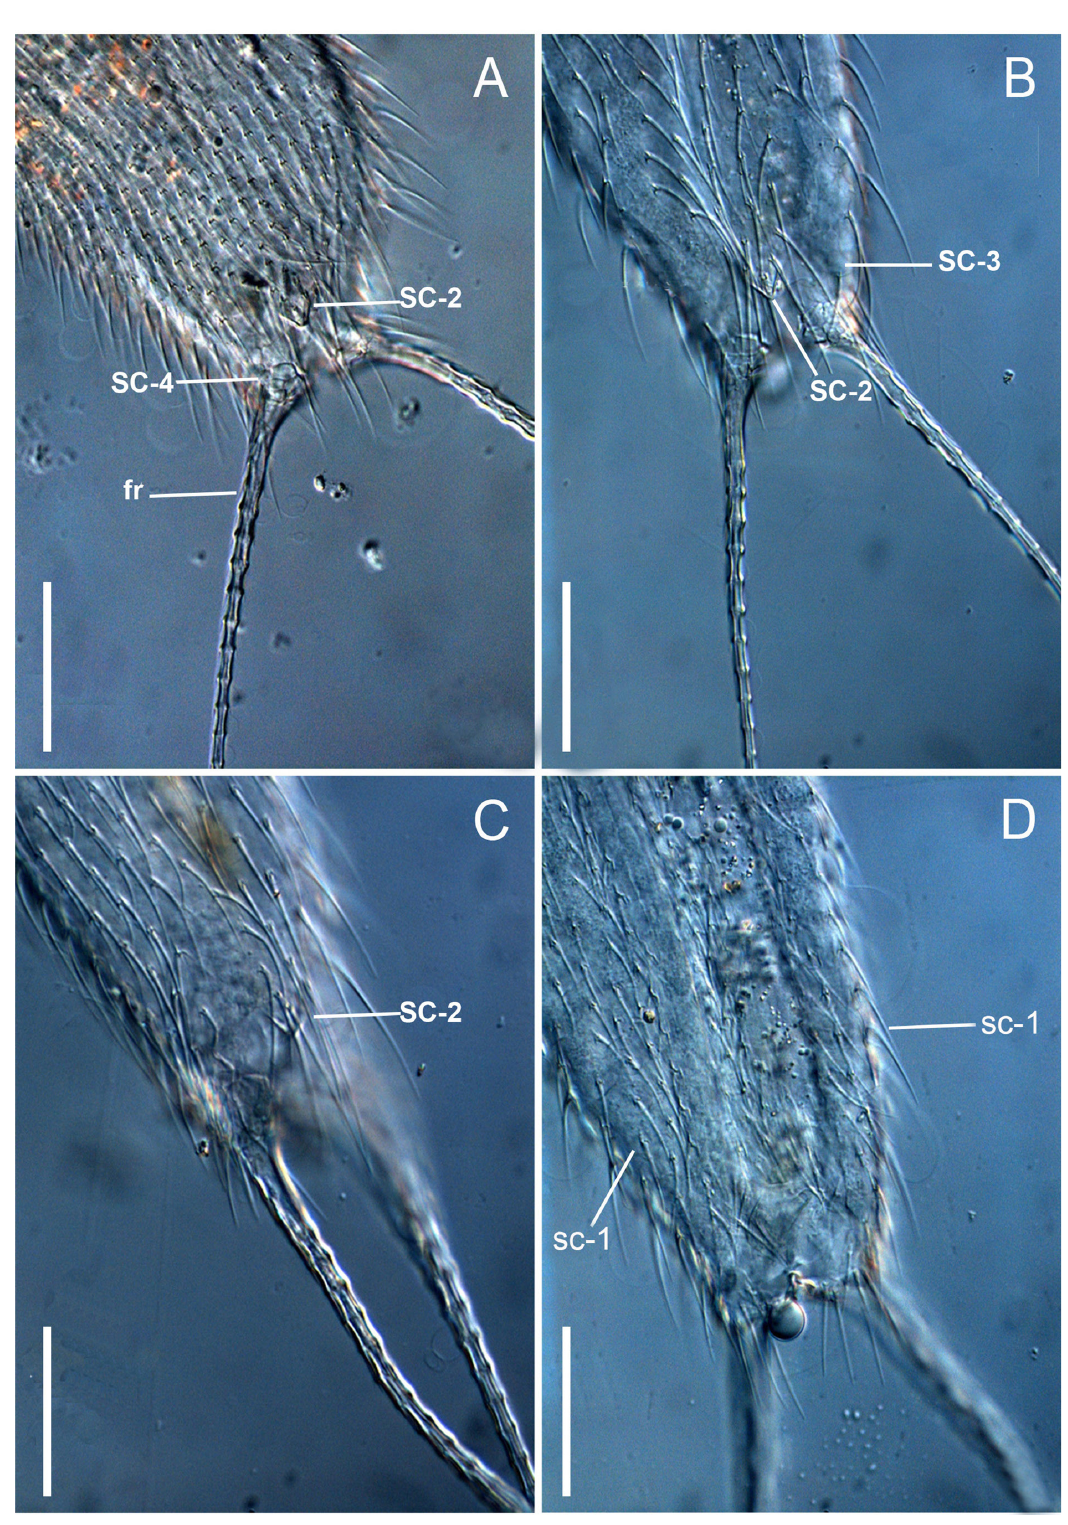
Fig. 4. Light microscopy – DIC. Polymerurus insularis sp. nov. Posterior region of the body. A . Paratype (ZUEC GCH 56). B, D . Holotype (ZUEC GCH 55). C . Paratype (ZUEC GCH 57). A–B . Posterior dorsal view. C . Posterior dorsolateral view. D . Posterior ventral view. Abbreviations: fr = furcal rami; sc-1 = Type 1 scales; sc-2 = Type 2 scale; sc-3 = Type 3 scales; sc-4 = Type 4 scales. Scale bars = 40